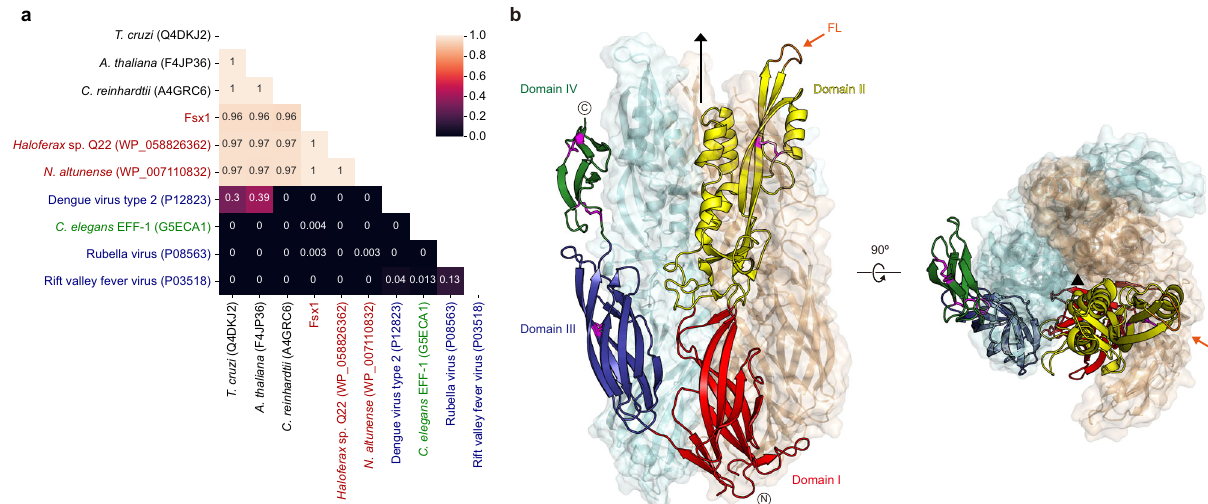
Fig. 1 Fsx1 is a member of the fusexin protein superfamily. a HMM vs. HMM homology probabilities of a subset of eukaryotic, viral, and archaeal fusexin ectodomains. With exception of Fsx1, which derives from a metagenomic sequence, archaeal fusexins (red), viral fusexins (blue), EFF-1 (green) and HAP2s (black) are indicated by RefSeq/UniProt identi fi ers. b Crystal structure of the trimeric ectodomain of Fsx1. The three-fold non-crystallographic axis is indicated. Subunit A is shown as a cartoon colored by domain, with disul fi des and the fusion loop (FL) colored magenta and orange, respectively; subunits B, C are in mixed cartoon/surface and interface similarity searches identify HAP2 as the closest structural homolog of Fsx1 E , followed by viral fusexins and C.